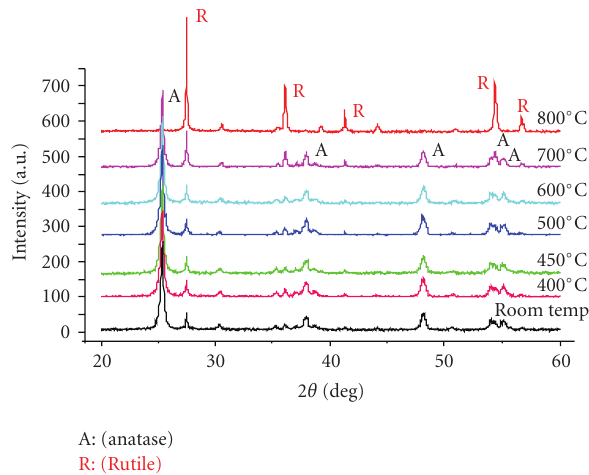
Figure 8: XRD spectra for the deposited TiO 2 nanoparticles sintered at various